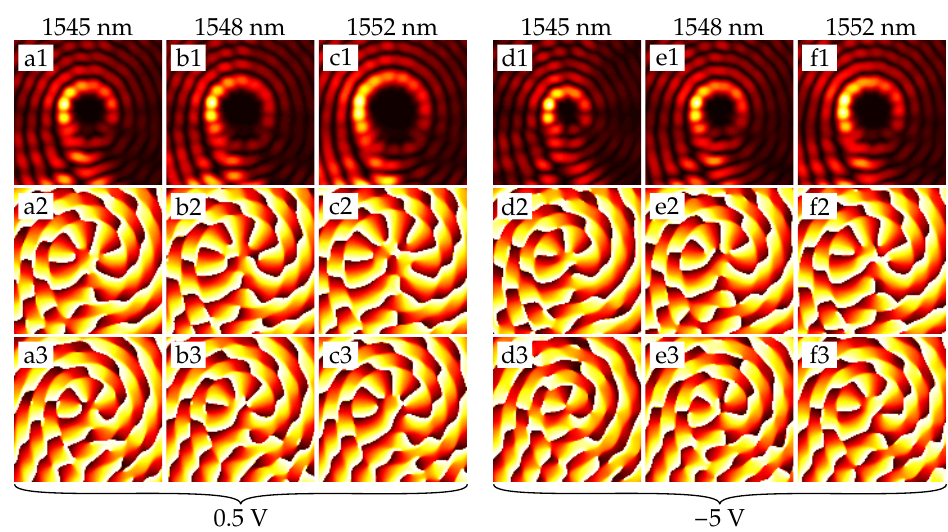
Figure 7. Intensity and phase distributions of the emitted fields from the ring with radius 26.5 µm. ( a1 – a3 ) is an intensity, arg ( E x ) and arg ( E y ) at a given resonant wavelength, respectively. Phase distributions are obtained after passing the field through the quarter-wave plate, so its x -component’s azimuthal order is above by one, and its y -component’s azimuthal order is below by one than the actual order of the generated vector vortex beam. Distribution patterns ( b1 – b3 )–( f1 – f3 ) are